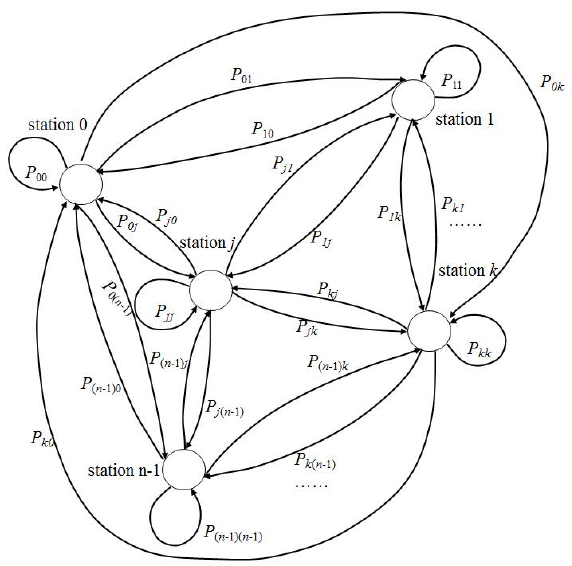
Figure 3. Transition states of all stations.